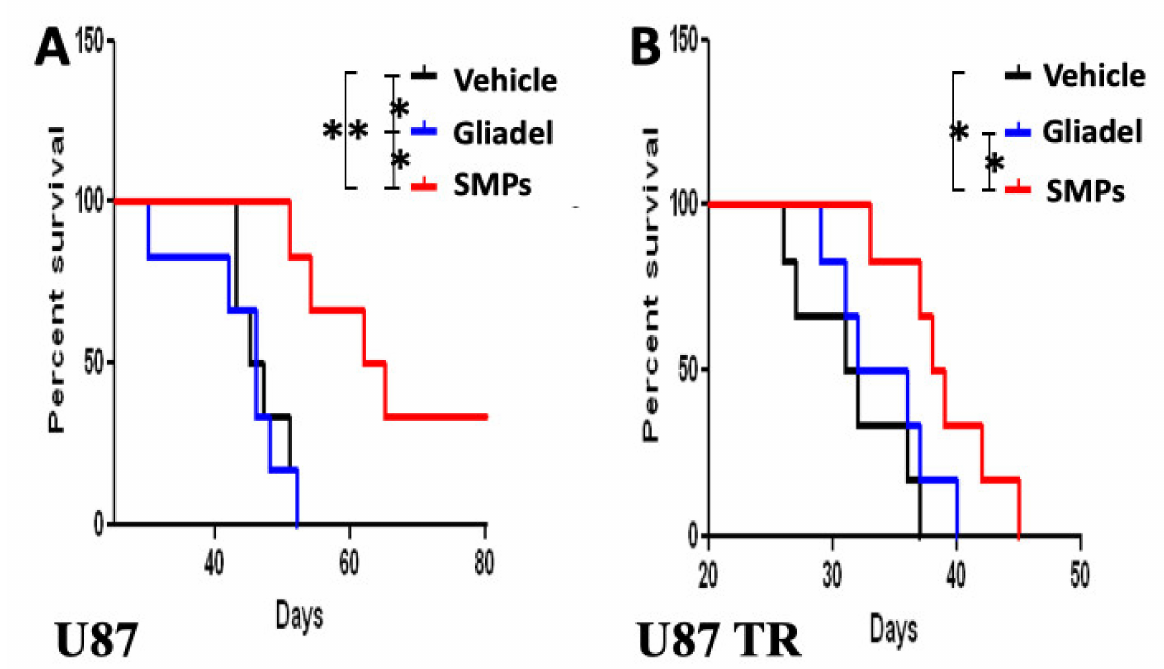
Figure 2. Kaplan–Meier survival curves of tumor-bearing mice following treatment with TMZ vehicle, TMZ-combined Gliadel, and TMZ-combined SMPs. ( A ) Survival curves of mice bearing U87 xenografts. ( B ) Survival curves of mice bearing U87-TR xenografts. The study was powered with eight mice per treatment arm for statistical significance. Log-rank (Mantel–Cox) tests were performed on survival plots. A Student t-test was performed to quantify differences in treatment arms (* p ≤ 0.05; ** p ≤